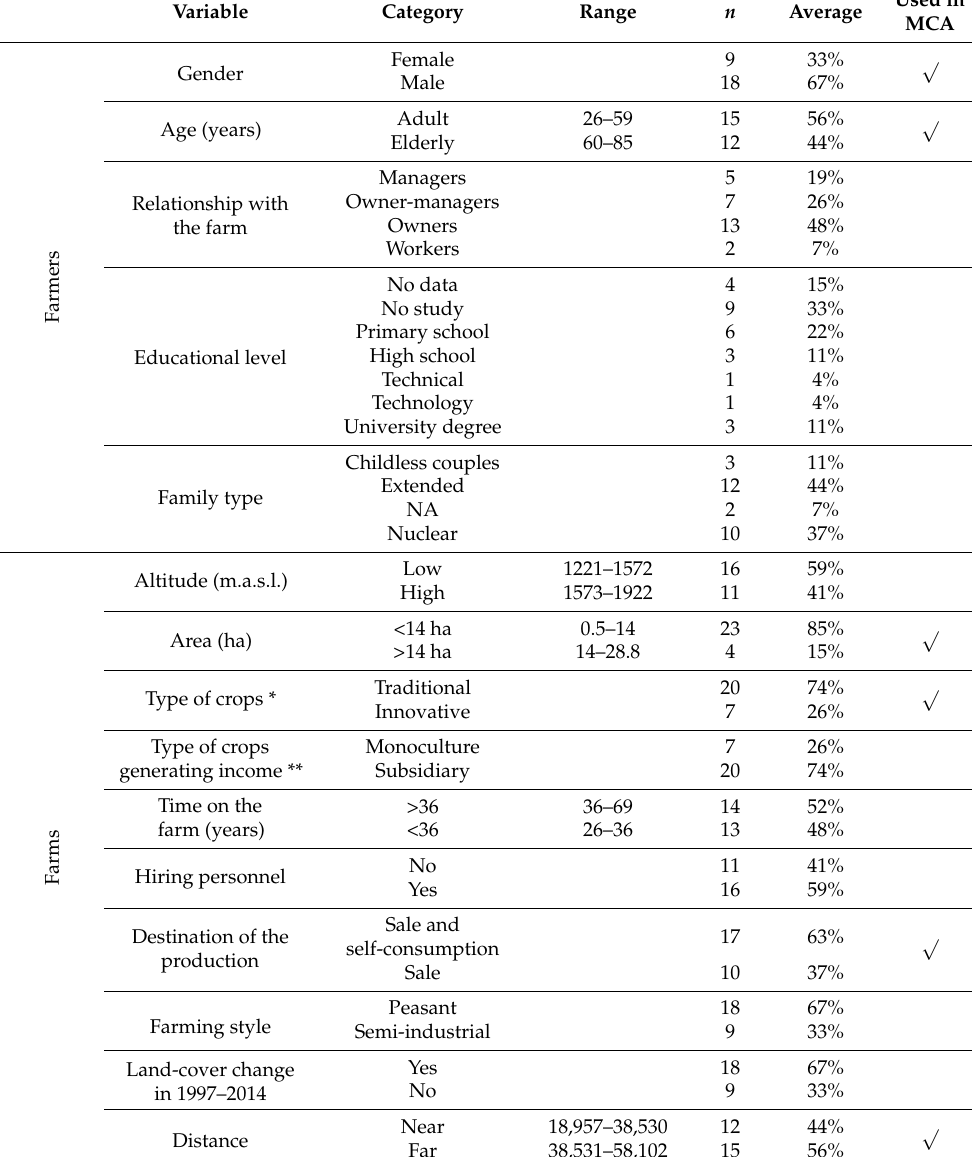
Table 1. Farmers and farms’ characteristics in the